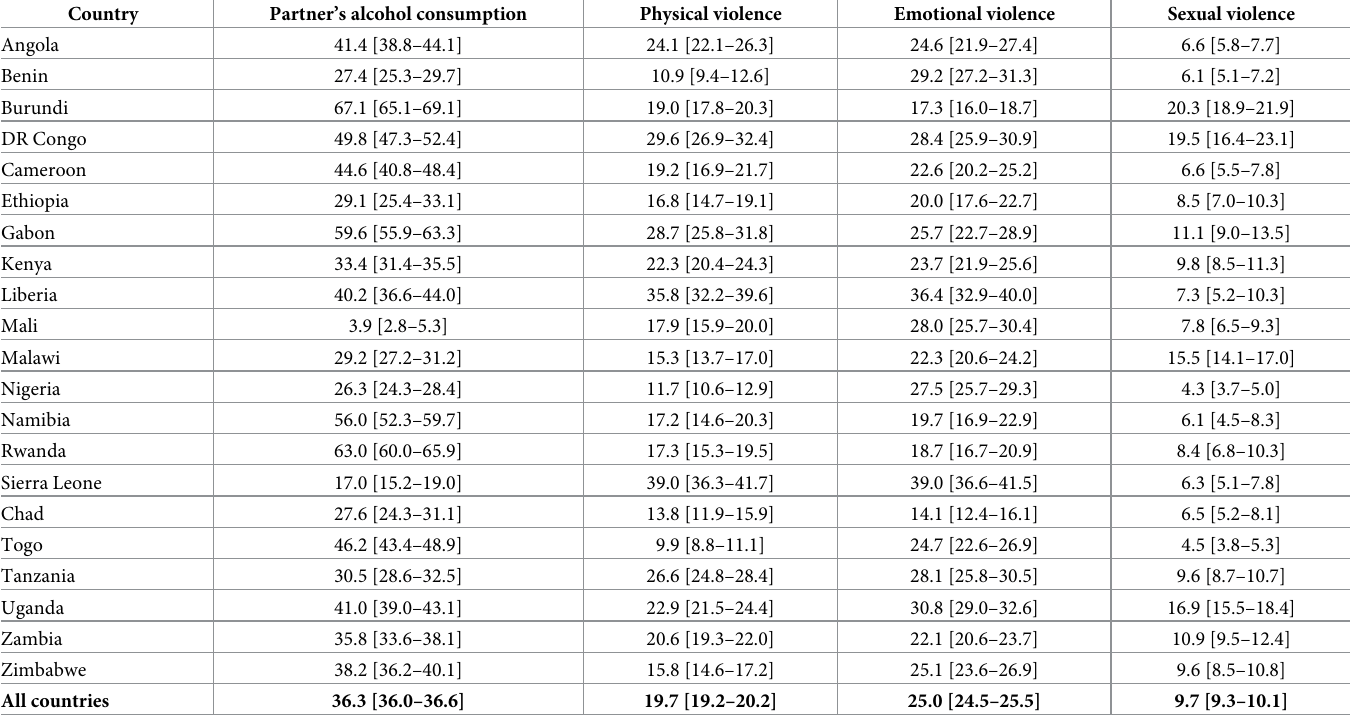
Table 2. Prevalence of partner’s alcohol consumption and intimate partner violence among women in sub-Saharan